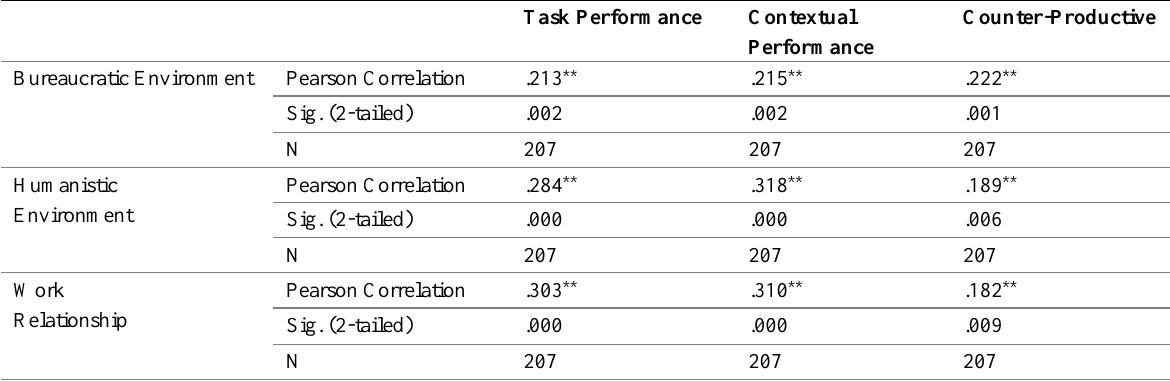
Table 12: Relationship between Work environment and Individual Work Performance Task Performance Contextual